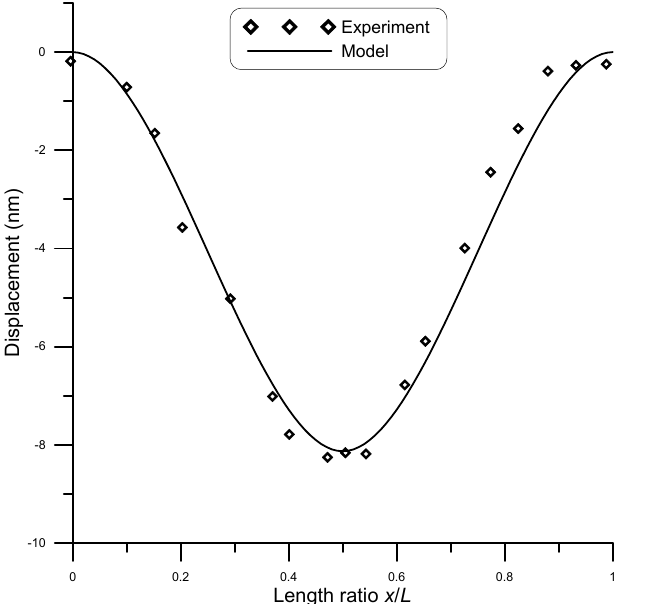
Figure 10. Displacement of a 1 µ m long beam of 85.4 nm diameter under point load of 81.7 nN, compared to experimental data